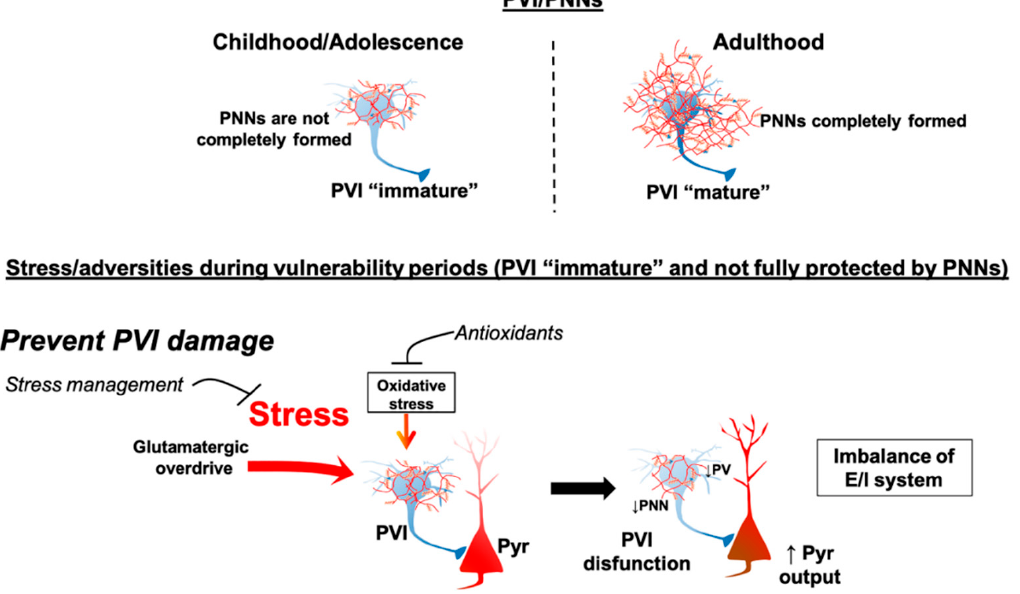
Figure 3. It is proposed that during childhood/adolescence PV interneurons (PVI) are not “mature” and are not yet protected by perineuronal nets (PNNs), a glycosaminoglycan matrix sheath that surrounds PVI to end the plastic phase, but also protect PVI from metabolic and oxidative damage. Thus, during periods when PNNs are not yet fully formed, PVI are more vulnerable to stress-induced damage. This vulnerability continues until adulthood. During adolescence, exposure to stress can increase oxidative stress and cause aberrant excitation onto PVIs leading to PVI damage/loss. This, in turn, results in deficits in the excitatory/inhibitory (E/I) balance producing circuit deficits that lead to SCZ-related changes. Therefore, treatments that mitigate the impact of stress, through stress management approaches and/or attenuation of oxidative stress with antioxidants, may protect PVI from damage and potentially prevent SCZ